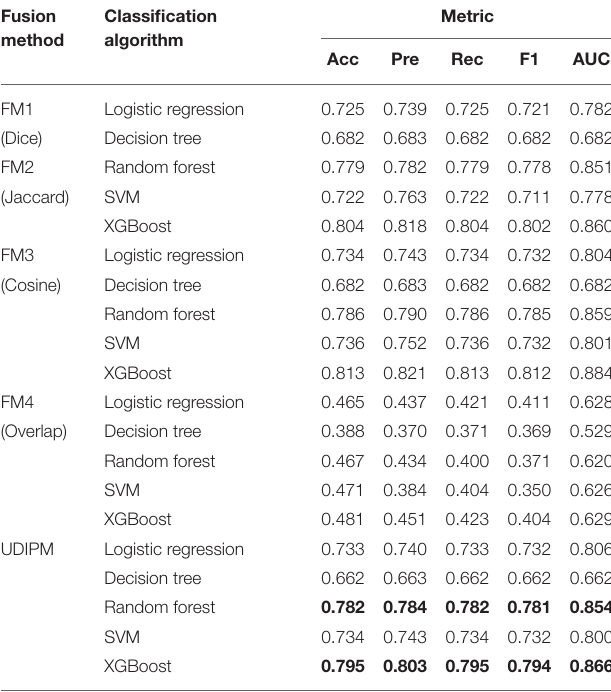
TABLE 5 | Classification results of different fusion methods.